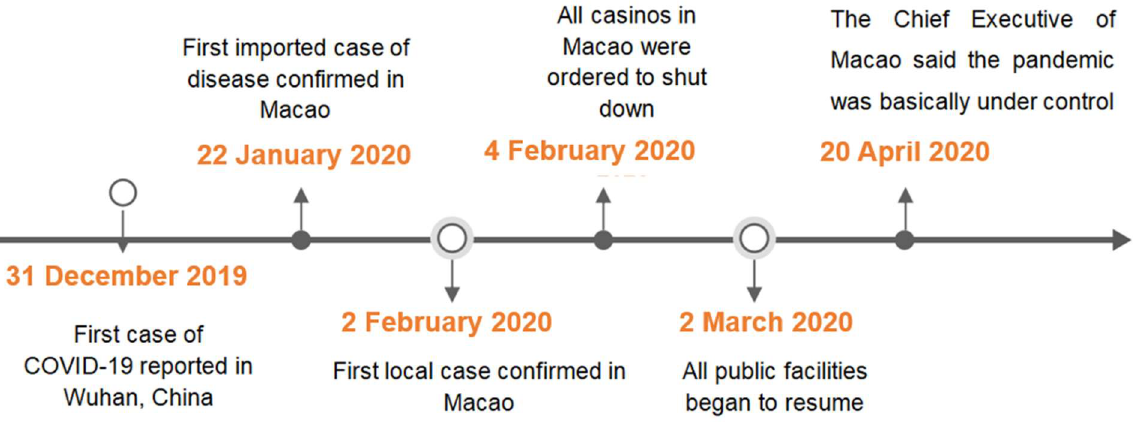
Figure 2. Timeline of the key events of the COVID-19 pandemic in Macao (1 January to 31 December 2020).